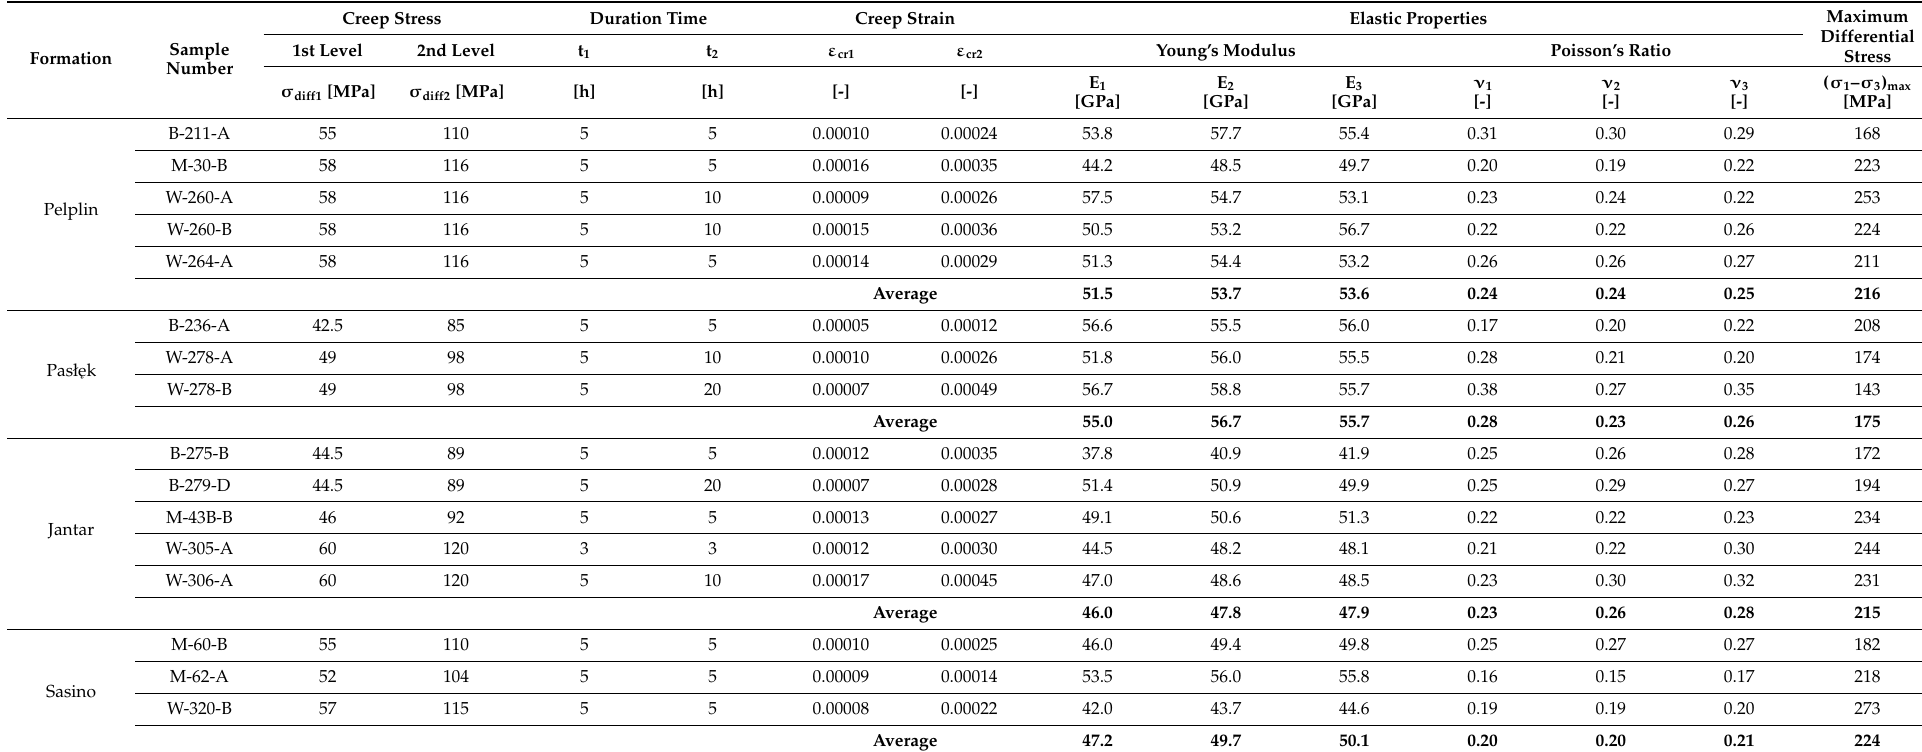
Table 3. Conditions of the performed studies and obtained results during viscoelastic creep tests for all analysed samples from the analysed claystone